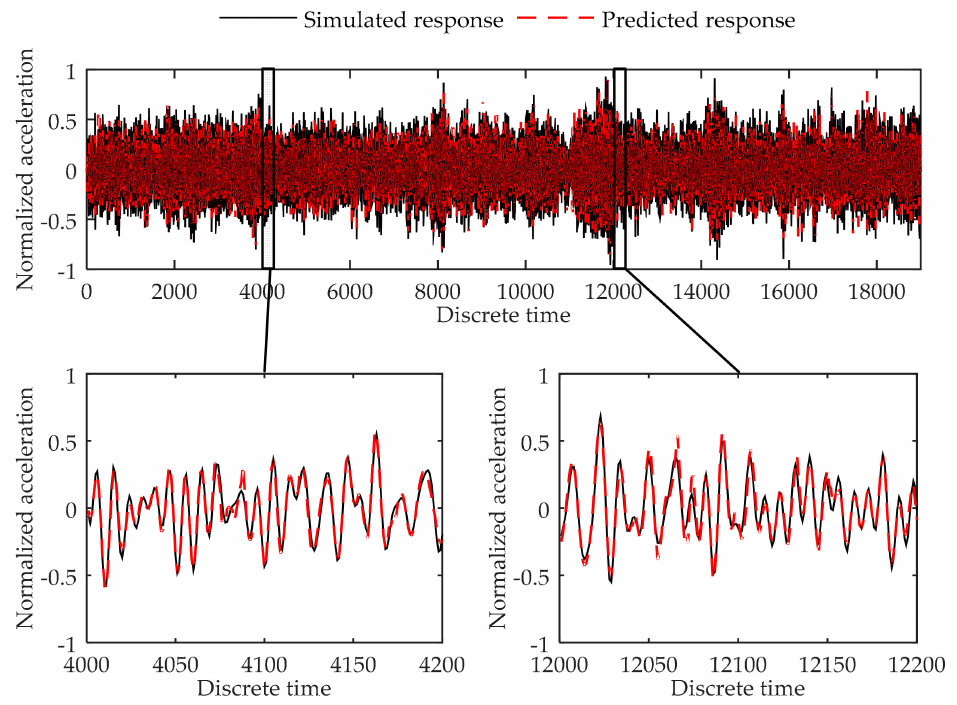
Figure 16. Comparison between the predicted response and real response of the location 6 at the simply supported beam experiment in Load Case